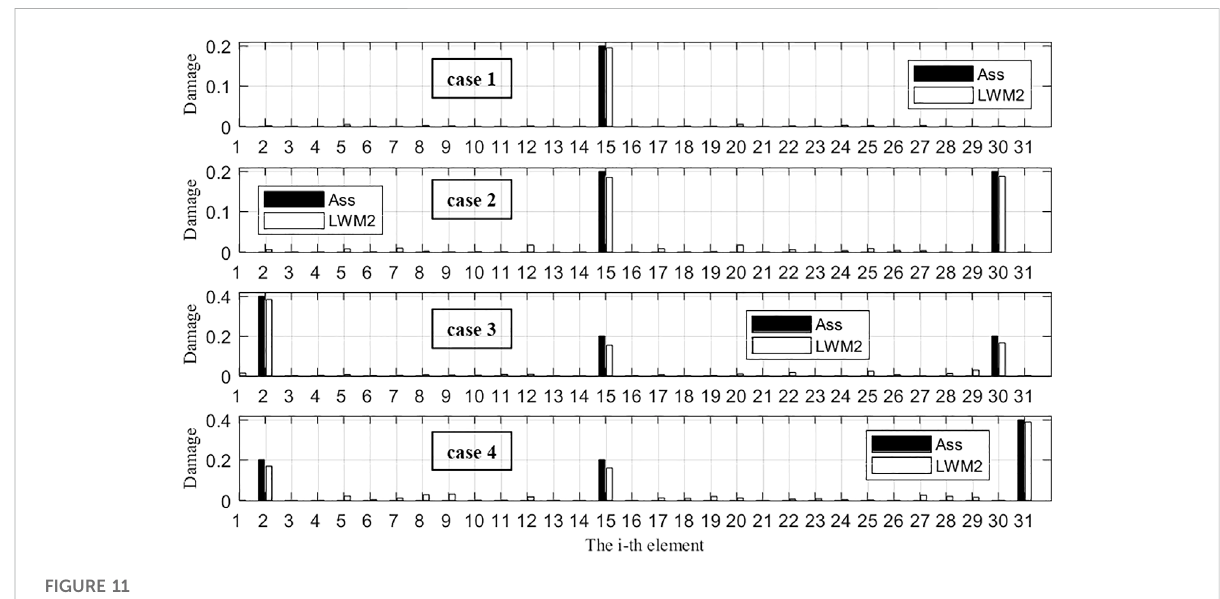
FIGURE 11 SDD results of the plane steel